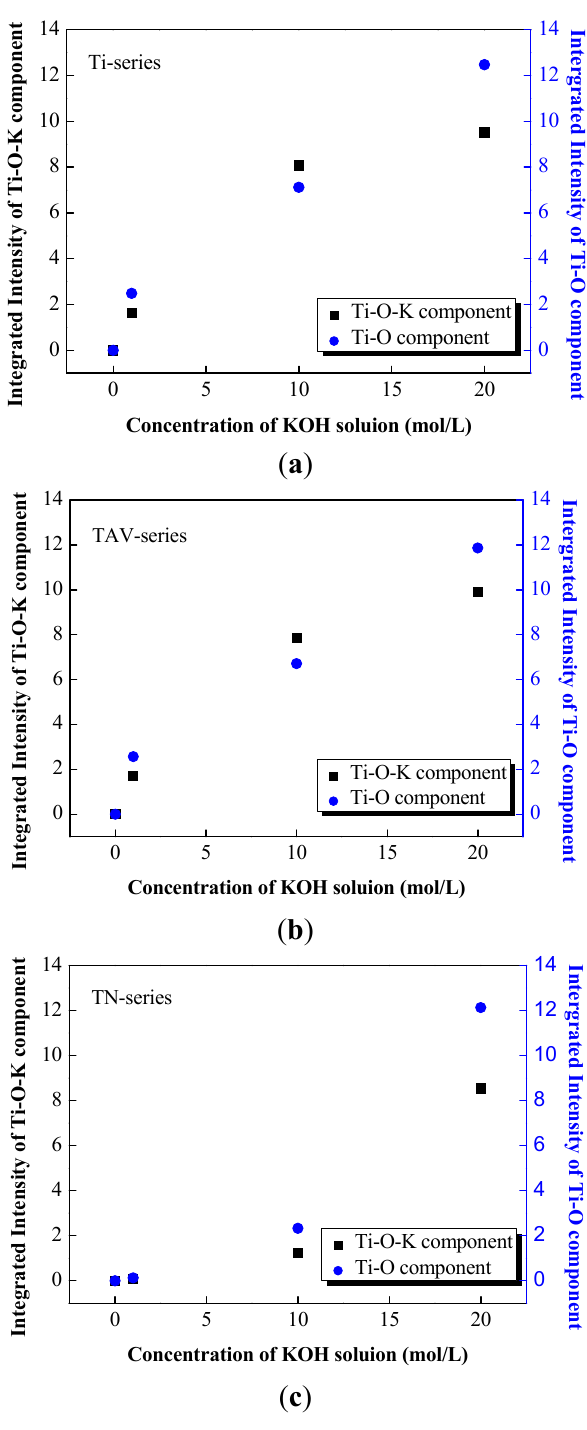
Figure 4. The integrated intensity of the Ti–O–K components and the Ti–O components in KOH-treated (1, 10 and 20 mol/L-KOH solution) Ti, TAV, and TN substrates estimated from the ambient Raman spectra. ( a ) The chart of the untreated and KOH-treated Ti substrates; ( b ) The chart of the untreated and KOH-treated TAV substrates; ( c ) The chart of the untreated and KOH-treated TN substrates. We can conclude that the amount of incorporated potassium is directly determined by the volume of the Ti–O–K component: the Ti–O–K component increased simultaneously with the increase in the concentration of the KOH